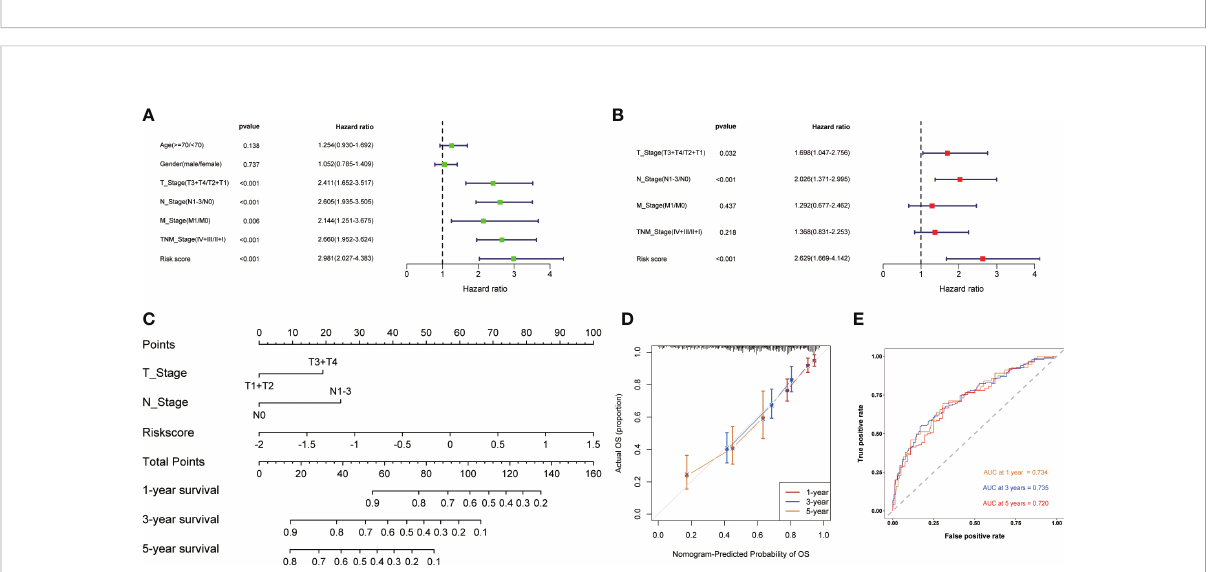
FIGURE 3 Transcriptional factor regulatory network and GO/KEGG enrichment analysis. (A) Regulatory network of key CMRGs and transcription factors. (B) GO enrichment analysis. (C) KEGG enrichment analysis.